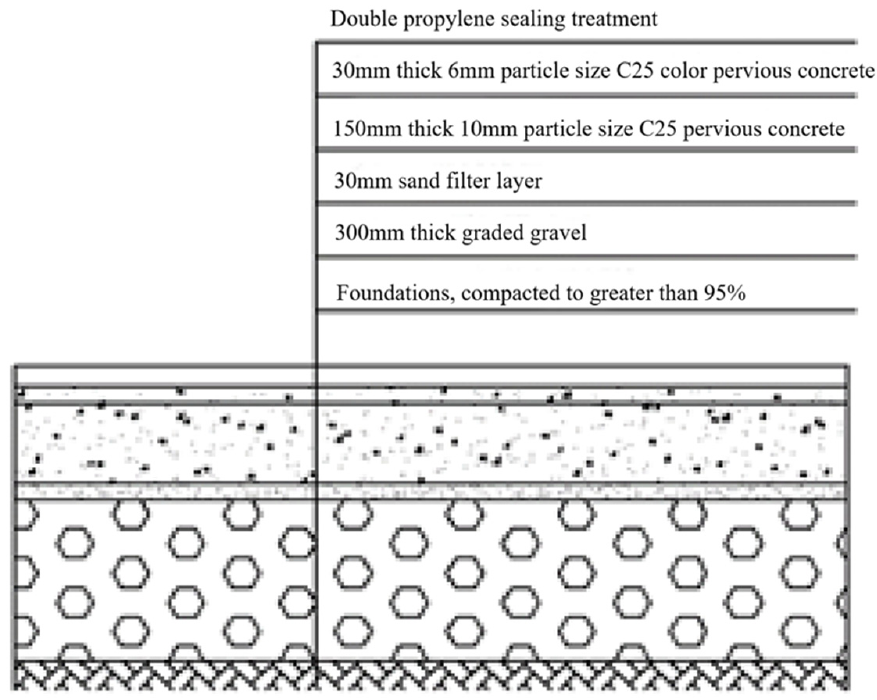
Figure 3. Cross-section of the permeable pavement structure installed at the case study’s site, Riverside Park.